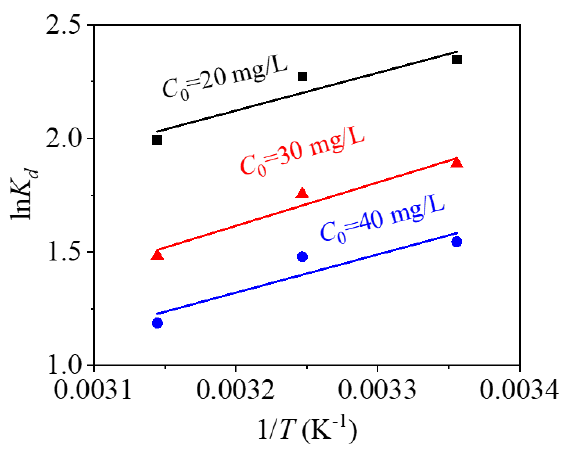
Figure 14. Thermodynamic fitting of the adsorption of Hg(II) by CoFe 2 O 4 @SiO 2 -EDTA.